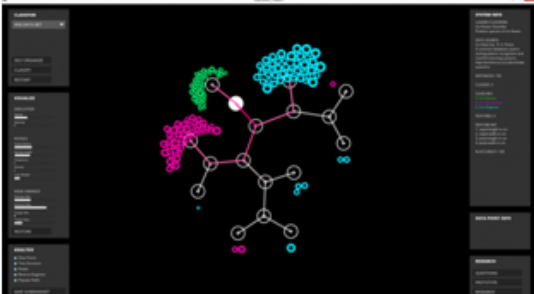
Figure 11 | Software interface for Visualizing Algorithms, an application to visualize, simulate, and interact with a simple machine learning classifier.